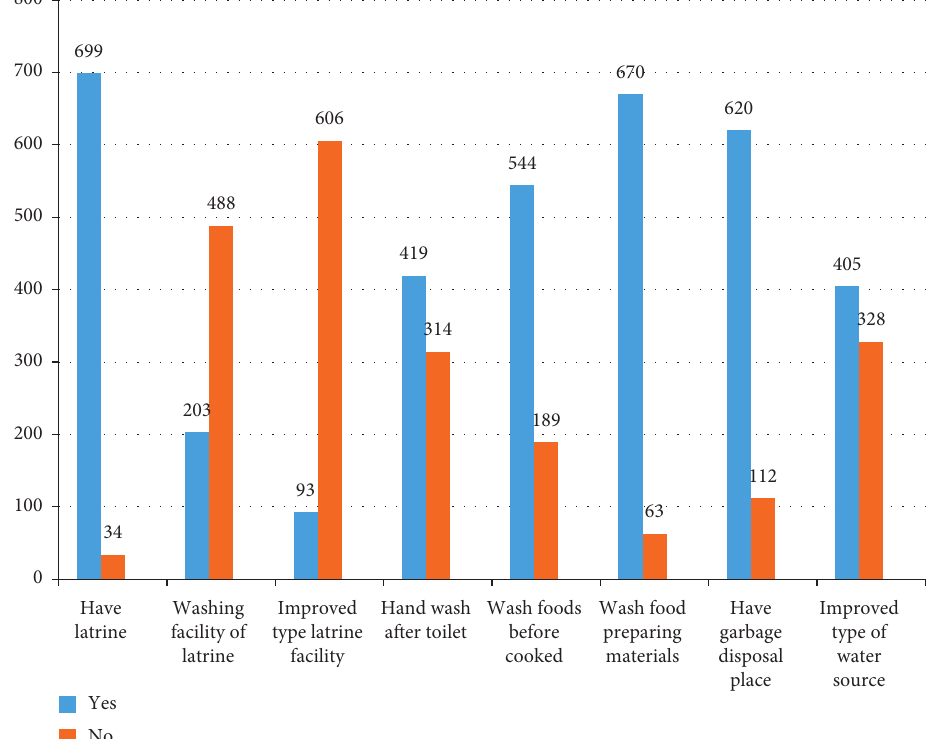
Figure 1: Water, sanitation, and hygienic practice of study participants among lactating women in Dega Damot Woreda, Northwest Ethiopia, March-April 2018 ( n � 733).